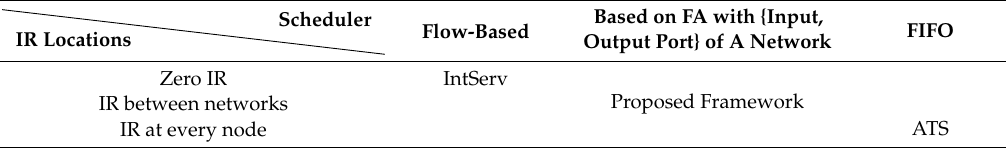
Table 3. Categorization of three frameworks based on the IR locations and the scheduler